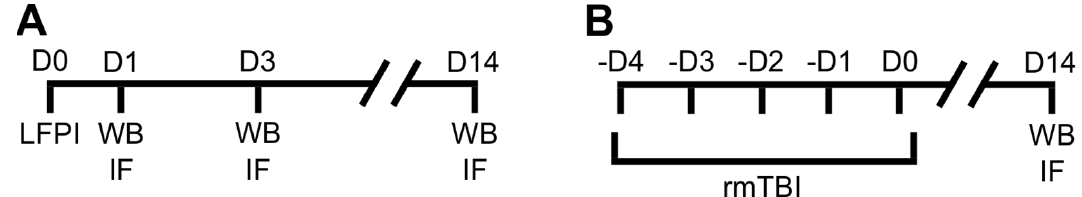
Figure 6. Experimental design and timeline of the experiments on mice subjected to ( A ) lateral fluid percussion injury (LFPI) of moderate severity or ( B ) repetitive mild traumatic brain injury (rmTBI). rmTBI group of mice was subjected to mild weight drop injuries twice daily, 5 d in a row. Mice of the LFPI group were sacrificed 1, 3, or 14 d after the injury, and animals exposed to rmTBI were euthanized at 14 d after the last head impact. Sham injured mice of the control groups for both LFPI and rmTBI experiments were sacrificed on day 1 after the experimental procedures. Different cohorts of mice were used for the Western blot (WB) and the immunofluorescent analyses (IF).